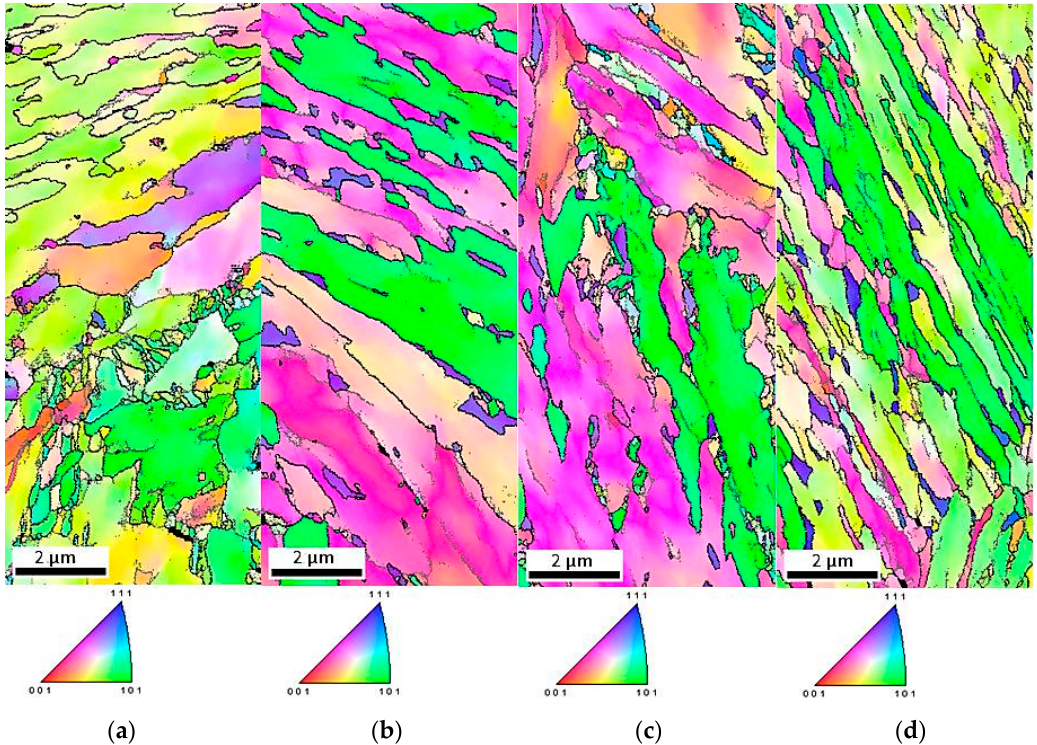
Figure 9. Inverse pole figures of the steel deformed at: 20 °C ( a ), 60 °C ( b ), 100 °C ( c ), and 200 °C ( d ).